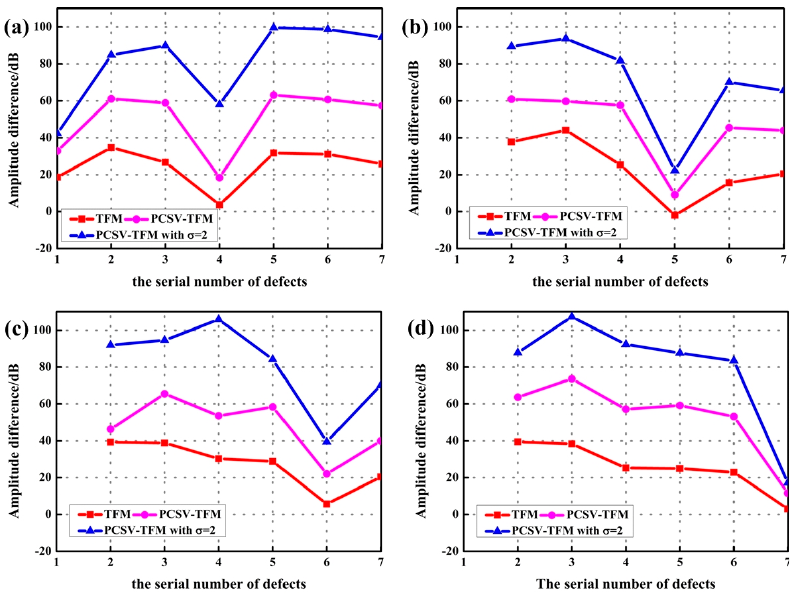
Figure 9. The amplitude difference between defects and the undesired echo around them at the depth of ( a ) the fourth defect covered; ( b ) the fifth defect covered; ( c ) the sixth defect covered; ( d ) the seventh defect covered; by using TFM, PCSV-TFM, and PCSV-TFM with power exponent σ =